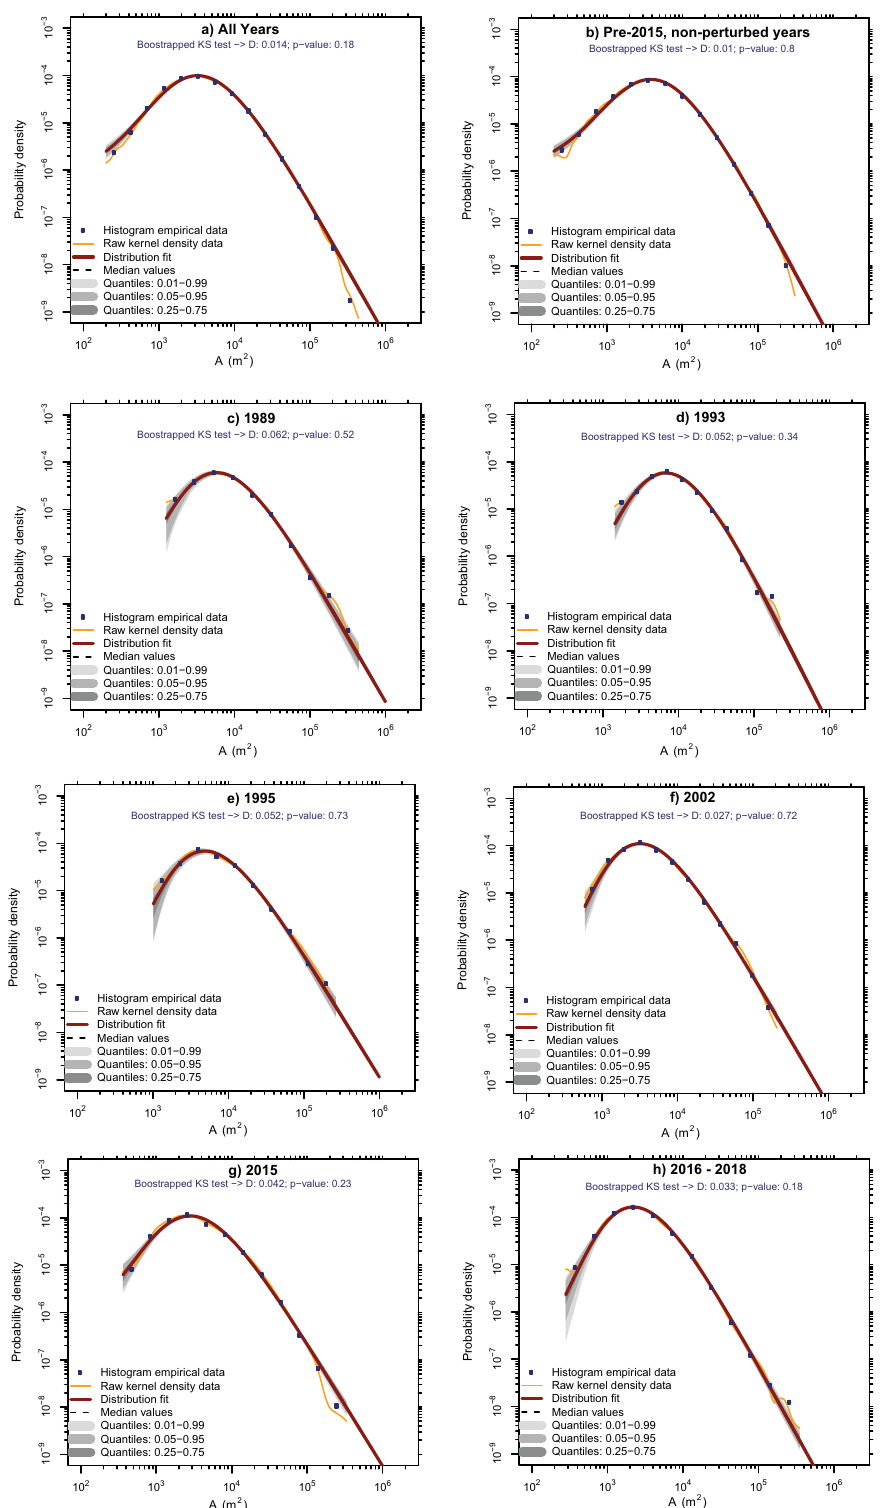
Fig. 4 Probability density functions (PDFs) of mass-wasting area fi tted with inverse-gamma power law distributions. These are shown for a all years, b the pre-2015 non-perturbed years, c 1989, d 1993, e 1995, f 2002, g 2015, h post-2015. All PDFs and fi tted distributions were calculated and plotted using the Landsat Software (version 10). Note that a p -value > 0.01 indicates that the three-parameter inverse-gamma distribution provides a good fi t to the actual data, whilst the D-value gives the maximum distance between the actual data and the fi tted distribution.